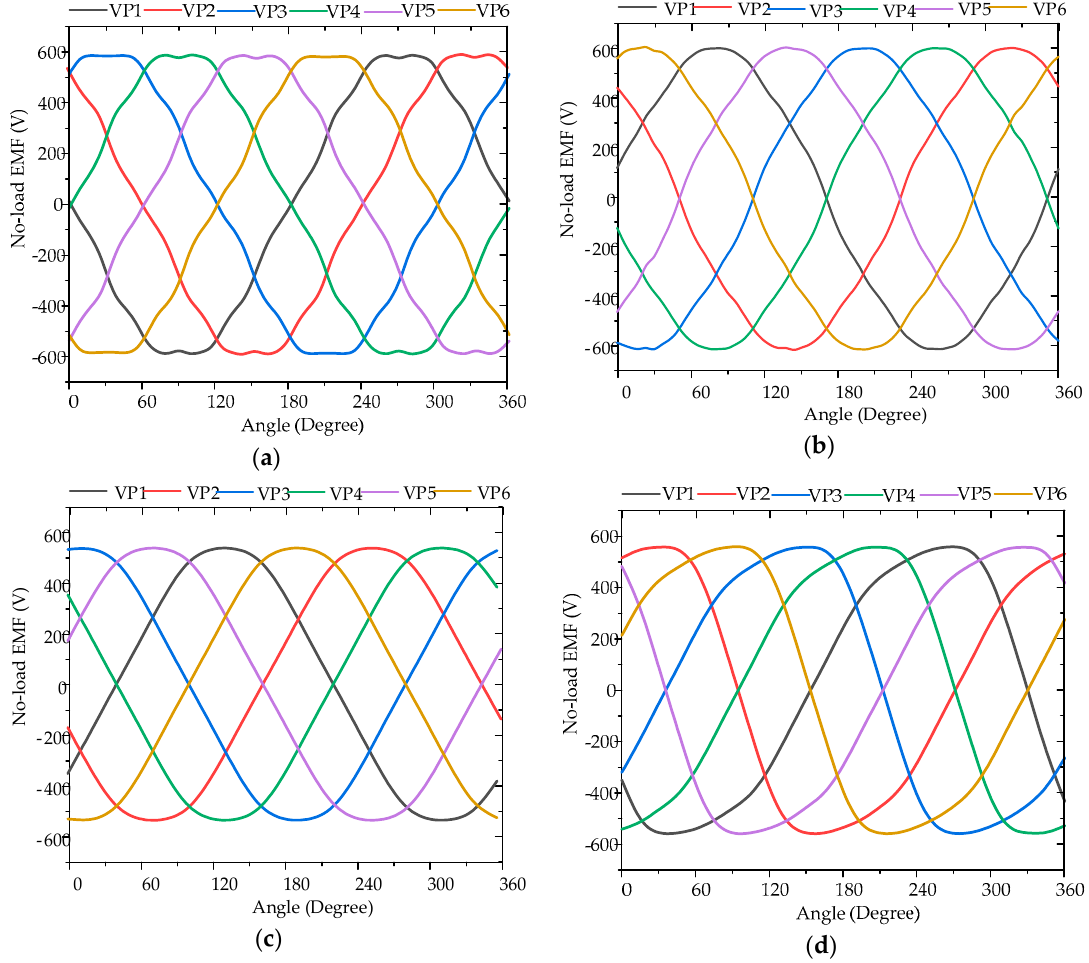
Figure 7. No-load EMF of proposed six-phase outer-rotor PM machines: ( a ) IPM type; ( b ) SPM type; ( c ) PMFS type; ( d ) PMV type.